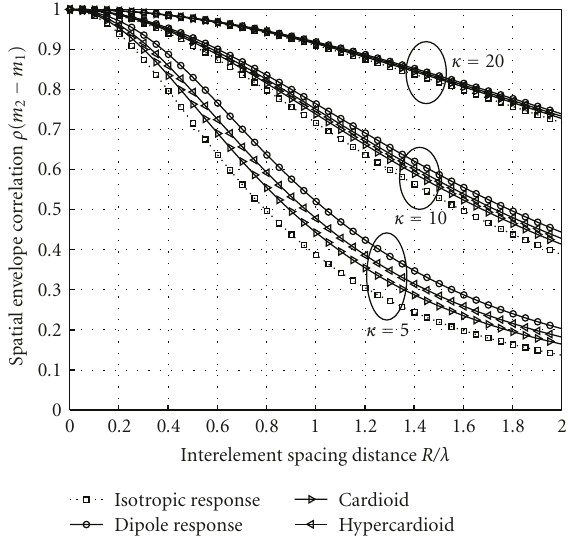
Figure 6: Spatial correlation estimates for all first-order antenna responses. The look direction for all antenna responses is set at ϑ , ϕ = 90 ◦ ,157 . 5 ◦ .